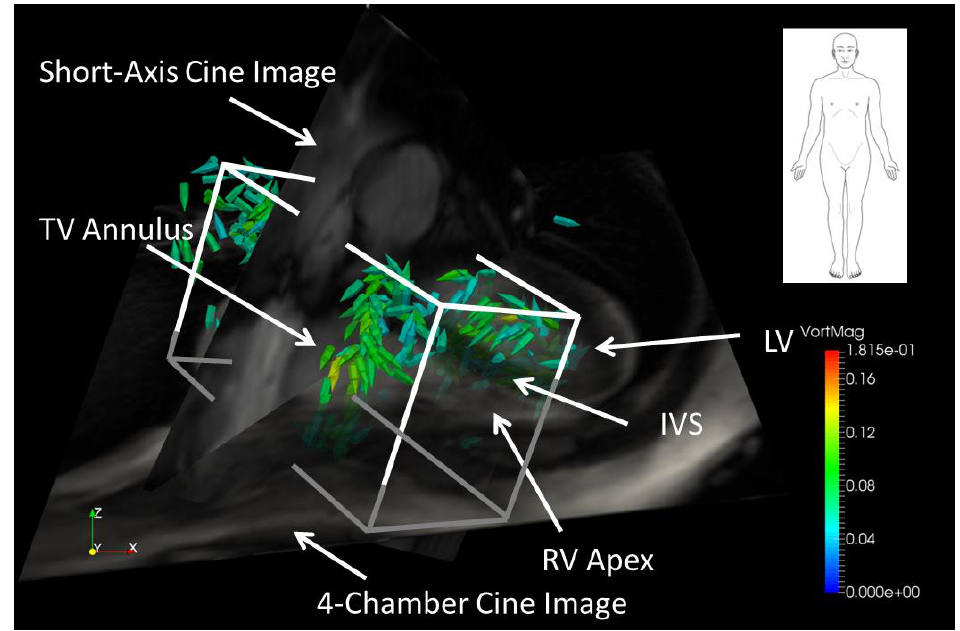
Figure 3. Vorticity vectors in a right ventricle (RV) volume during early diastole in a healthy subject. The cuboid encloses the RV volume used for volumetric vorticity integration. The red-scale 4-chamber view is semi-opaque and the short-axis view is fully opaque.